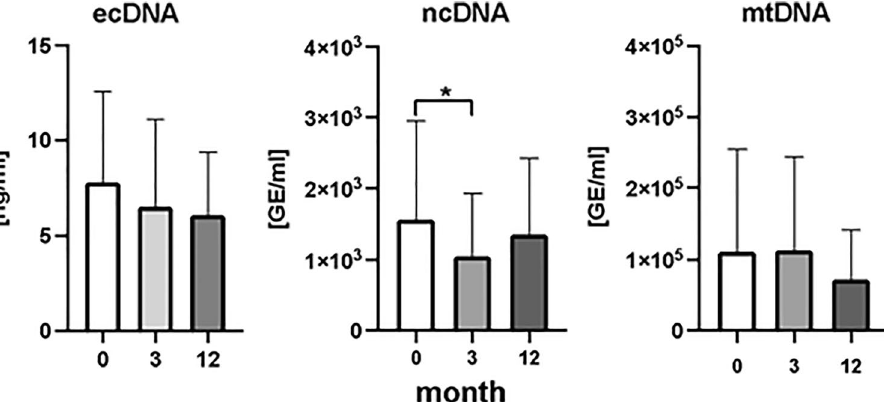
Figure 3. Concentration of total extracellular DNA (ecDNA), nuclear DNA (ncDNA), mitochondrial DNA (mtDNA) in patients with rheumatoid arthritis, before the initiation of bDMARDS and 3 and 12 months during ongoing treatment ( p < 0,05 = *, p < 0.01 = **, p < 0.001 =